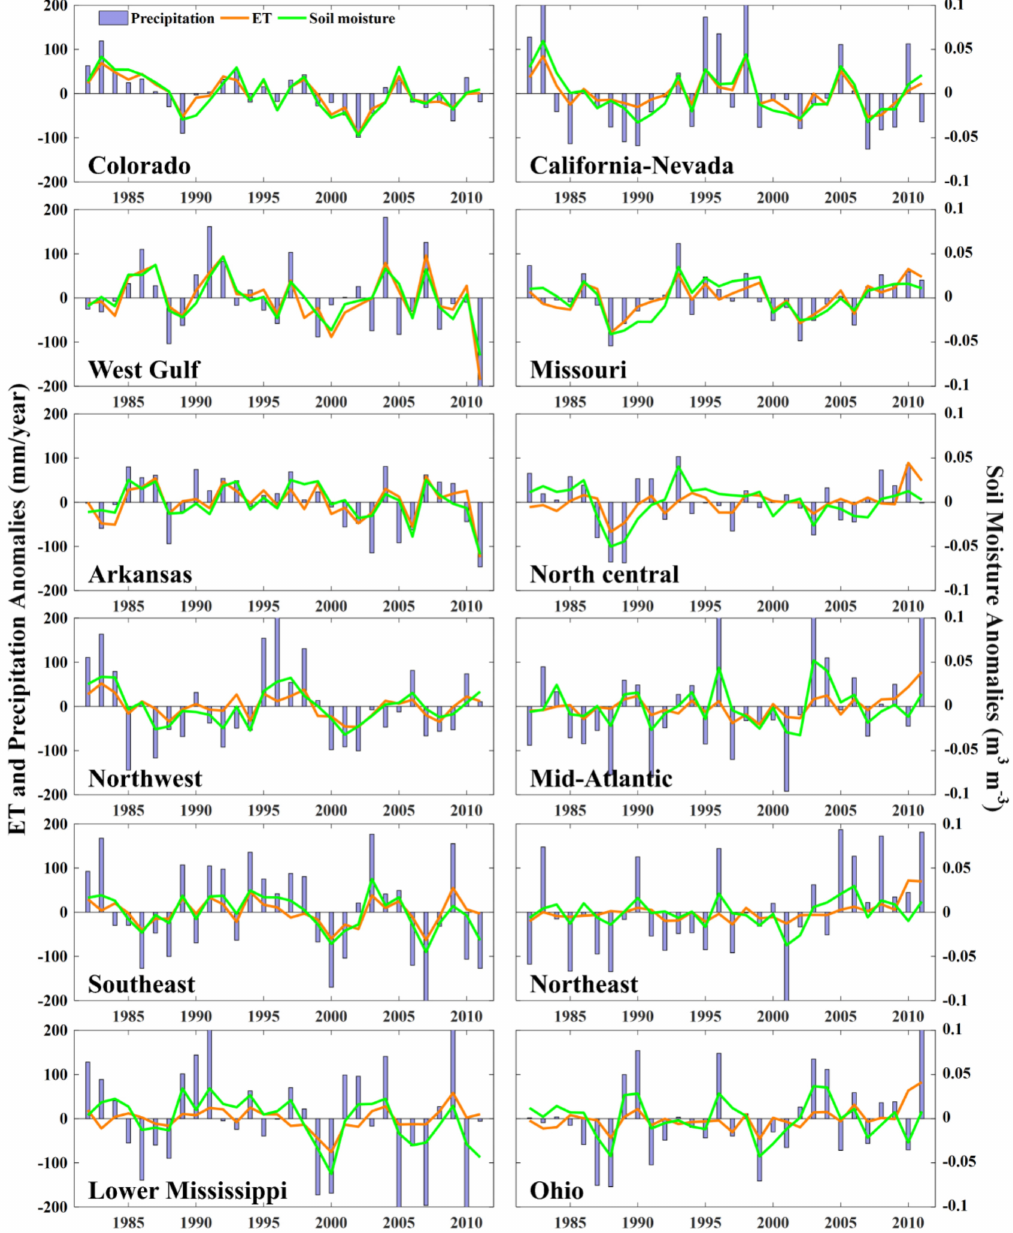
Figure 10. Annual variations of BTCH-integrated evapotranspiration (ET), soil moisture, and precipitation anomalies for 12 river forecast centers (RFCs) from 1982 to